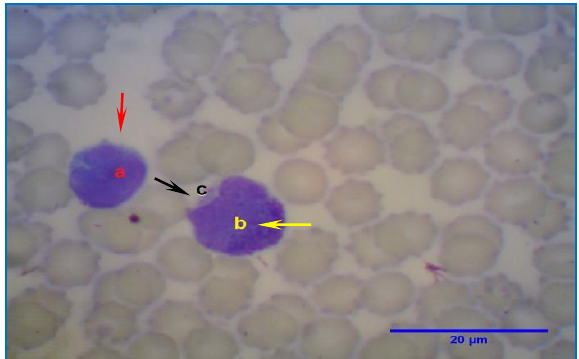
Figure, 6: (a) Small functional monocyte, (b) Basophil, (c) Pale cytoplasm (100x × 1.3